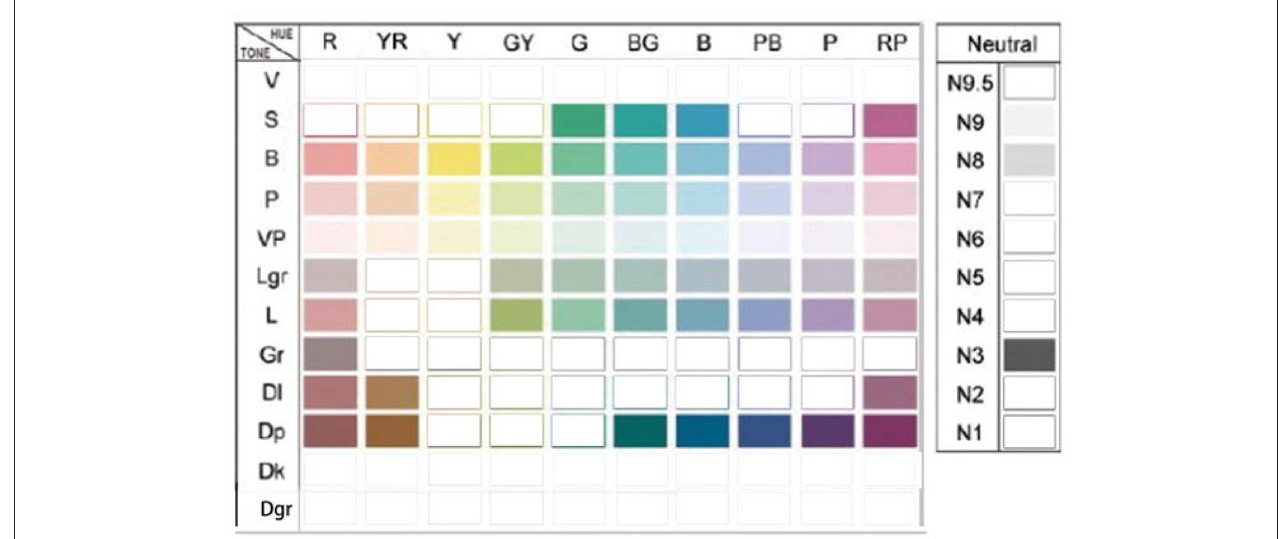
FIGURE 3 | Hue and tone distribution of cosmetics packaging in China and abroad.